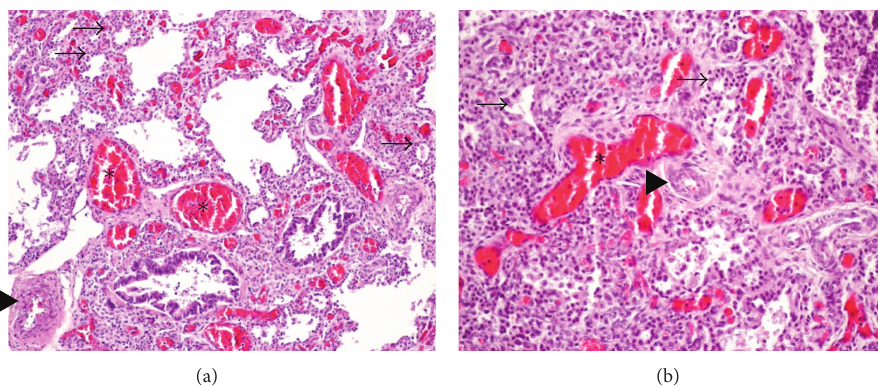
F 1: Case report 2: necropsy lung histology (hematoxylin and eosin staining) demonstrates the characteristic histologic features of ACD/MPV: thickened alveolar septae with scarce dilated pulmonary capillaries located away from the alveolar epithelium, with absence of the usual alveolar-capillary barrier ; medial hypertrophy of small pulmonary arteries and muscularization of distal arterioles ( congested pulmonary veins malpositioned, adjacent to pulmonary arteries in the same adventitial sheath ( (→)